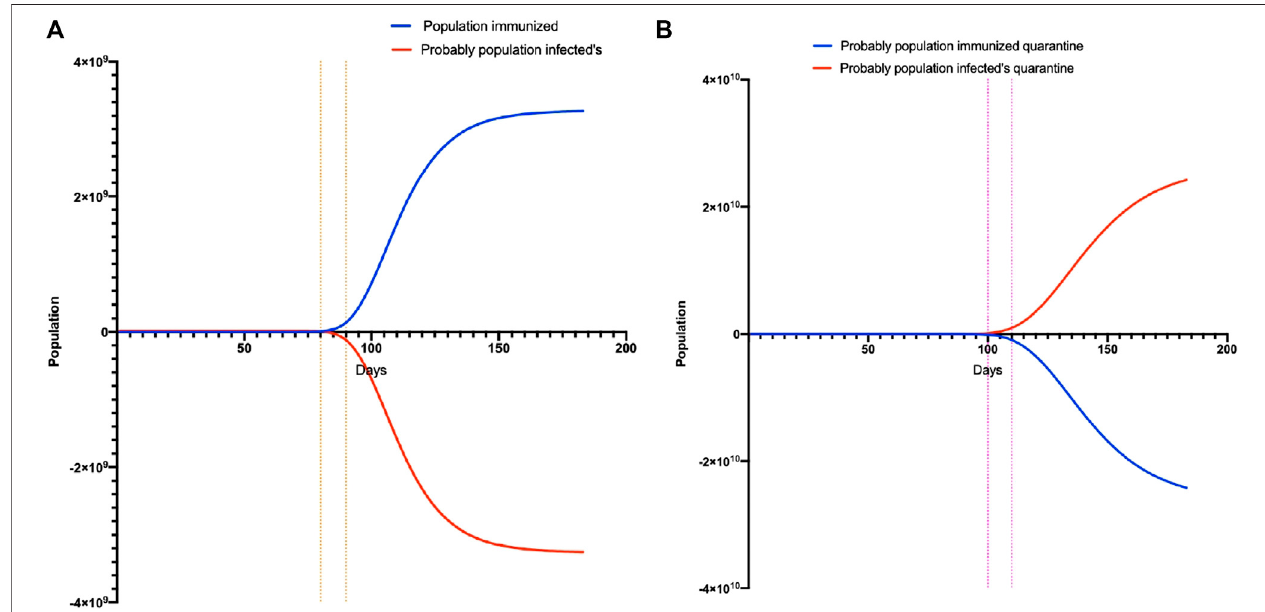
FIGURE8| Calculationmodeltoreachherdimmunity. (A) isthemodelwithoutquarantineandshowsthetimethatmustpassforherdimmunitytooccur. (B) isthe model with quarantine and shows the time that must pass for herd immunity to occur.